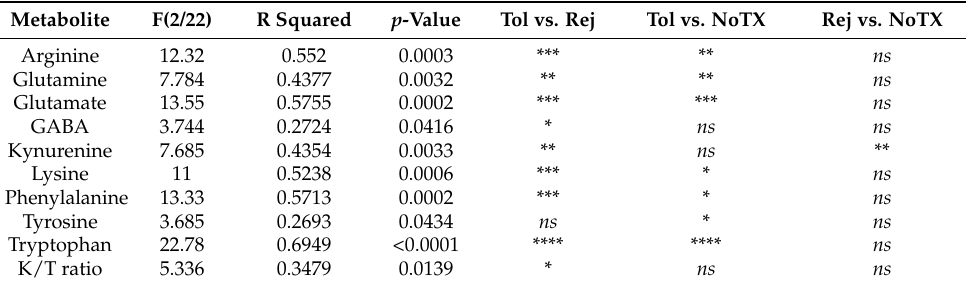
Figure 2. Several metabolites were identified in the electropherograms (EPGs) of aqueous humor (AQH) samples and had significantly different concentrations in the of non-transplanted controls (NoTX; black) and the transplant recipients that either rejected (red) or tolerant (green) their intraocular islet allografts. Concentrations were measured as indicated above and in Methods section based on the spiked standard solutions, and data were shown as box and whisker plots indicating the medians (horizontal lines in each box) and the upper and lower quartiles with all data points shown as open round symbols corresponding to each sample from one mouse ( n = 7 mice for NoTX and n = 8 mice for rejected and tolerant). Asterisks denote significant difference by ANOVA followed by Tukey’s multiple comparison test with * p < 0.05; ** p < 0.001; *** p < 0.0001; **** p < 0.00001 (also see Table 1 for more details). Table 1. Tuckey’s multiple comparisons for metabolites (amino acids and small primary amines) identified in the immediate local microenvironment of islet allografts under the various experi- mental conditions.